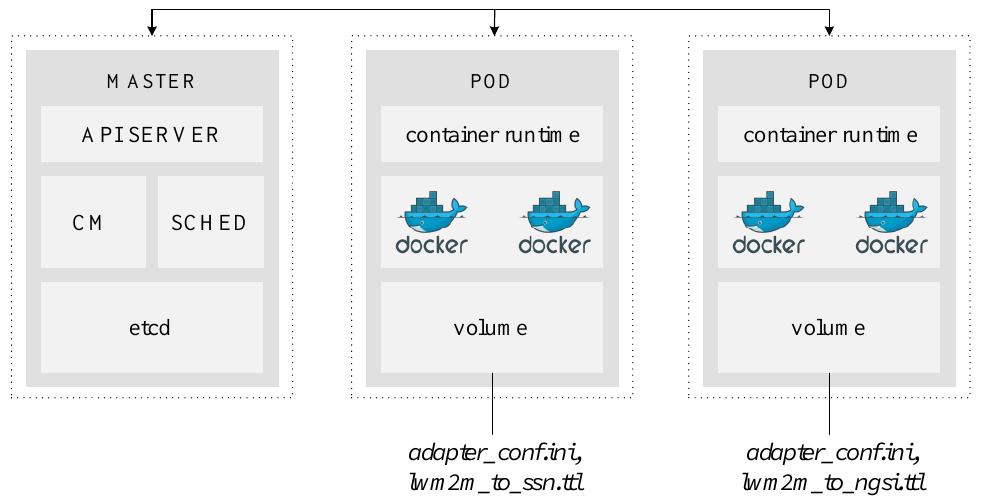
Figure 8. An excerpt of a FLINT system in a Kubernetes environment. Every Kubernetes deployment consists of (at least) two Docker containers—the sink and the agent. Both containers can be configured by mounting configuration files. Every deployment is managed by the Kubernetes